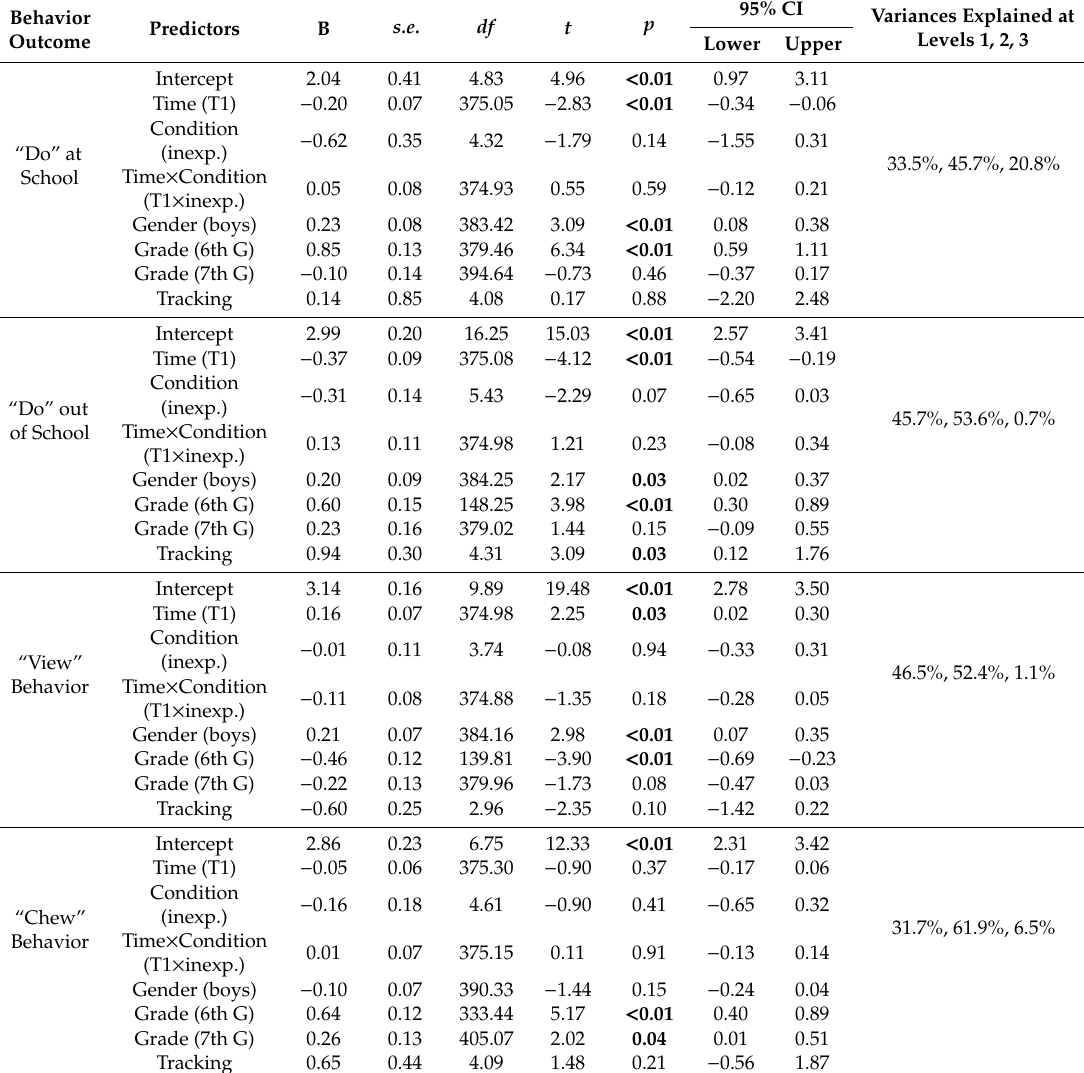
Table 3. Results from Four Sequential 3-Level Linear Mixed Models for “Do” at School as Outcome